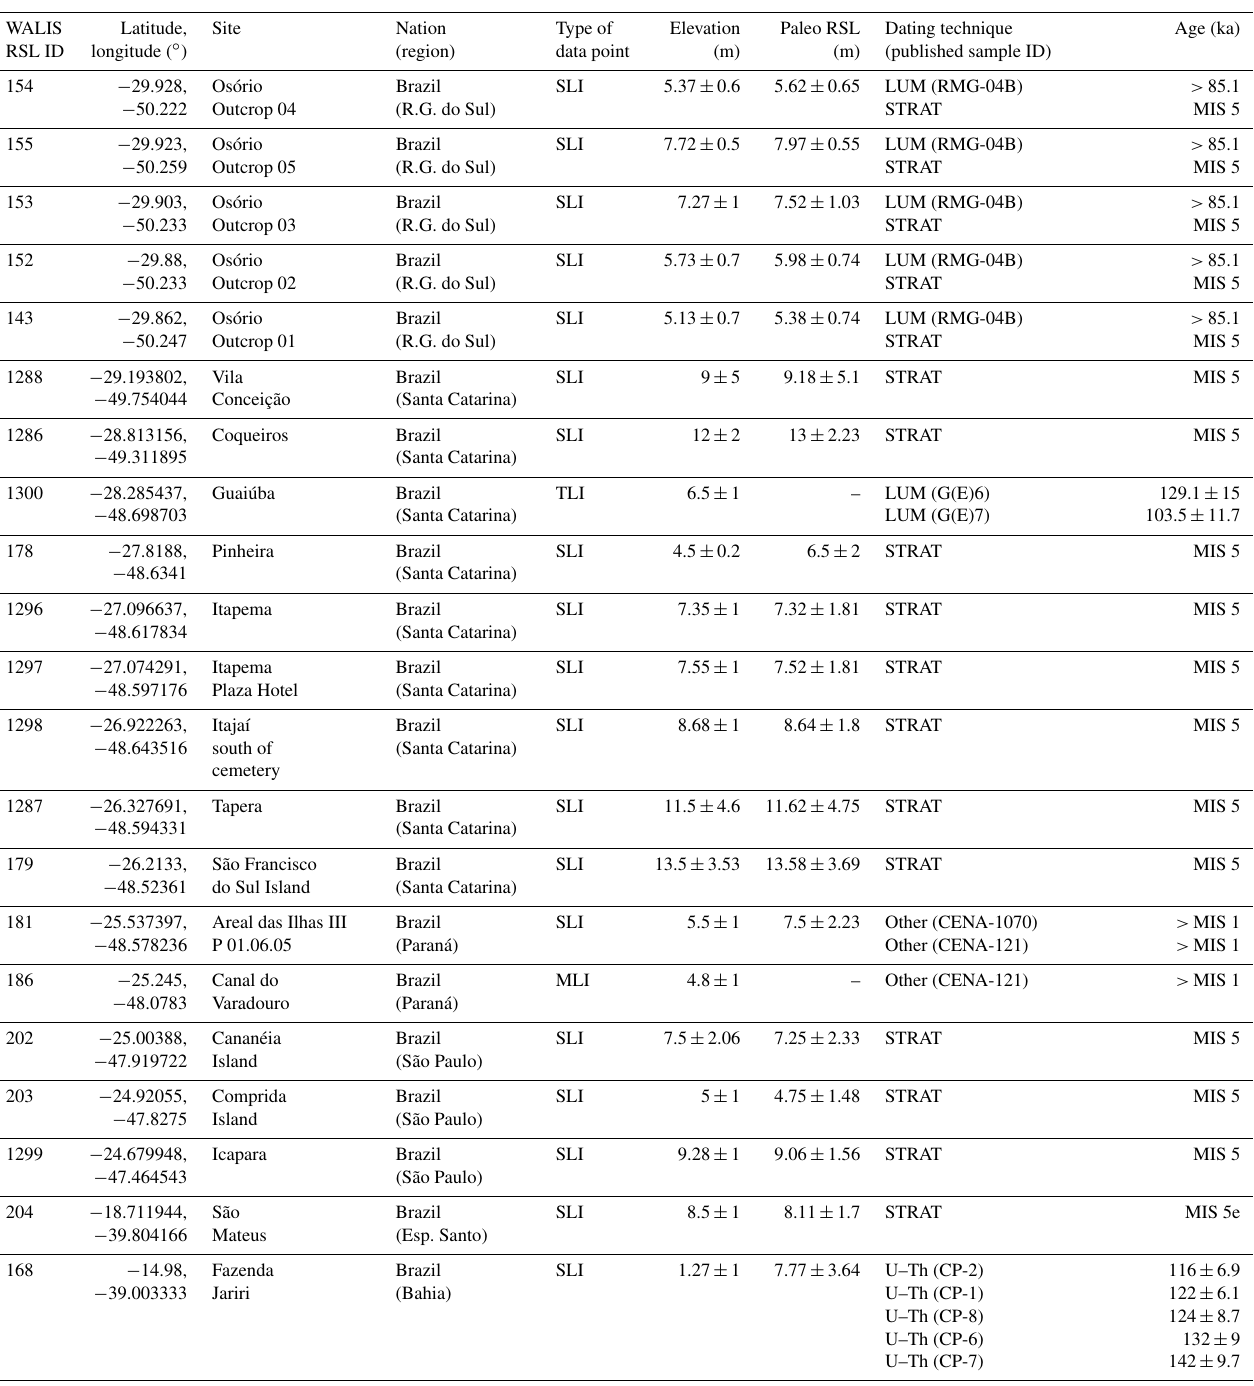
Table 3. Proxies compiled in this study. Elevation and paleo RSL errors are reported as 1 σ ; age uncertainties (where an absolute age is indicated) are 2 σ . Type of data points: SLI denotes sea-level indicator; TLI denotes terrestrial limiting; MLI denotes marine limiting. Dating techniques are abbreviated as follows: LUM is luminescence; STRAT is chronostratigraphic constraints; Other is other age attribution; U– Th is U series; ESR is electron spin resonance. ∗ denotes ages recalculated by Chutcharavan and Dutton (2021). For the U-series ages on Bonaire, Brocas et al. (2016) report the following average ages: 1 BON-5-A is 121 ± 1 . 1ka. 2 BON-26-A is 124 . 9 ± 1 . 9ka. 3 BON-24-AII.2 is 125 . 5 ± 2 . 4ka. 4 BON-12-A is 123 . 9 ± 1 .